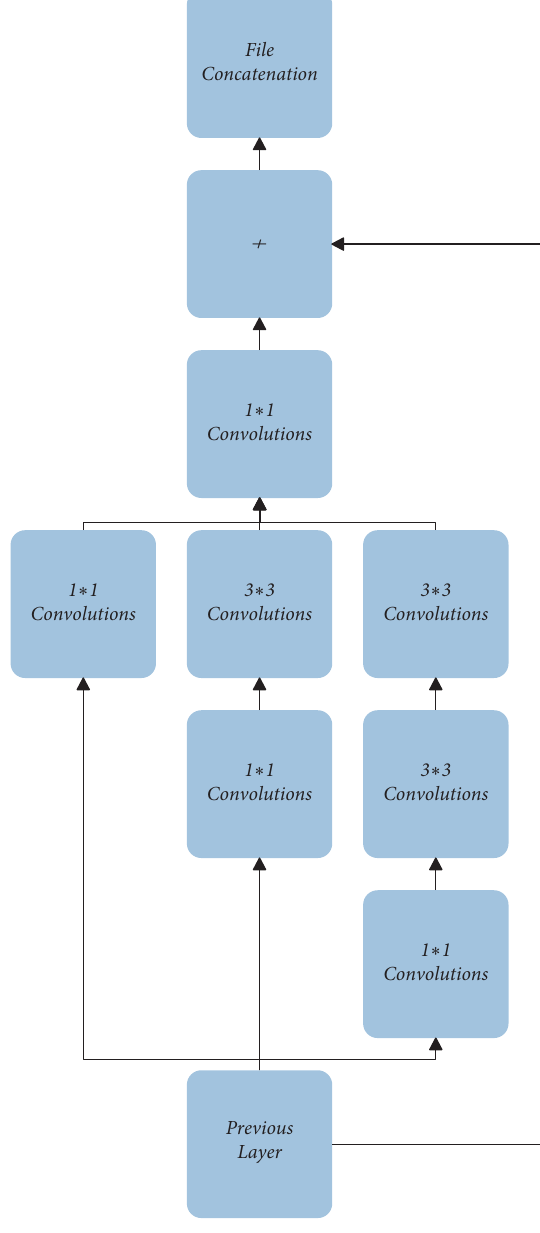
Figure 6: Inception-ResNet